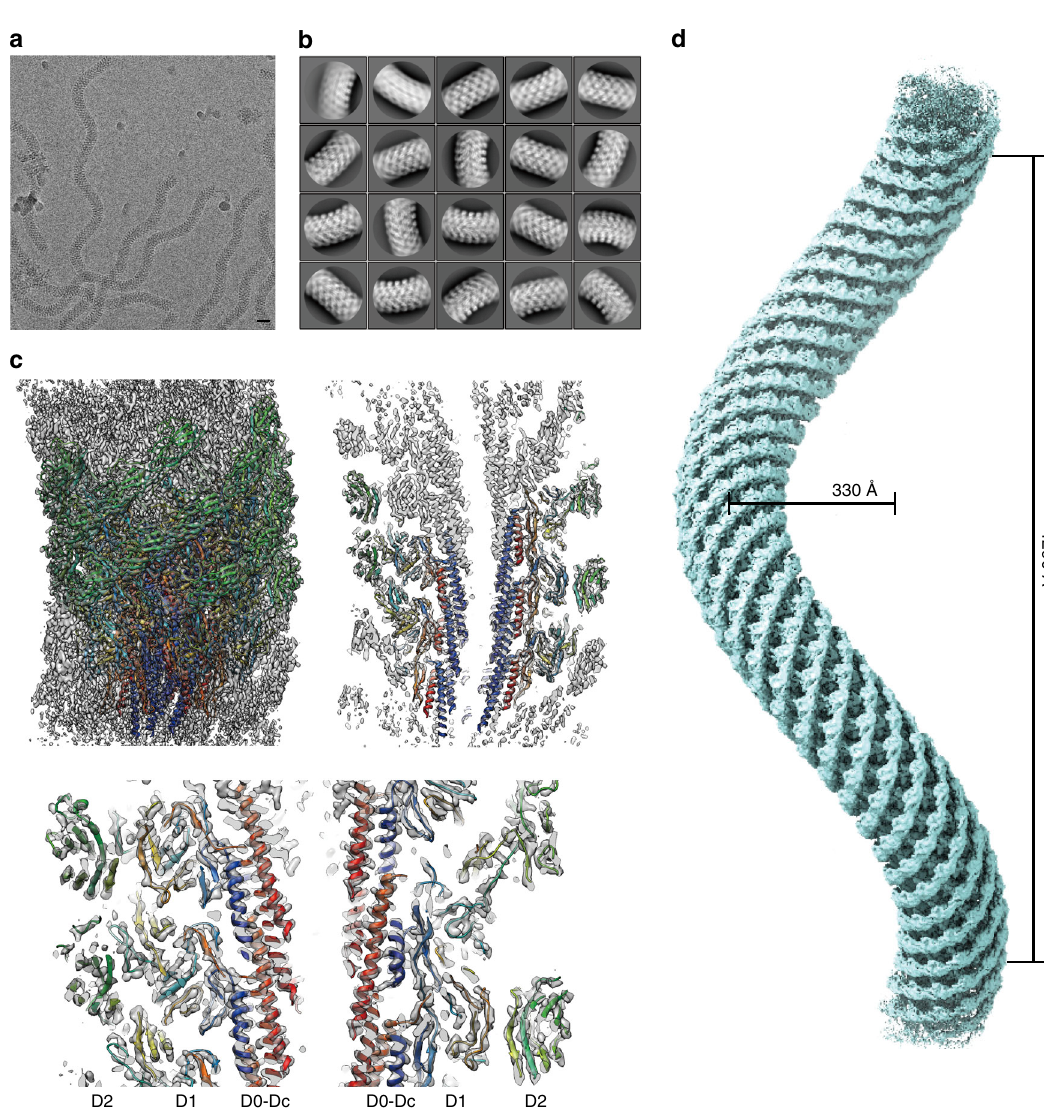
Fig. 1 Structure of native supercoiled hook. a A cryoEM image of ice-embedded native supercoiled polyhook. Scale bar, 20 nm. b Class averages by 2D classi fi cation. c Reconstructed density map and atomic models of FlgE subunits in ribbon representation colored in rainbow from the N- to C-terminus. d A density map of supercoiled polyhook extended to the length of one helical